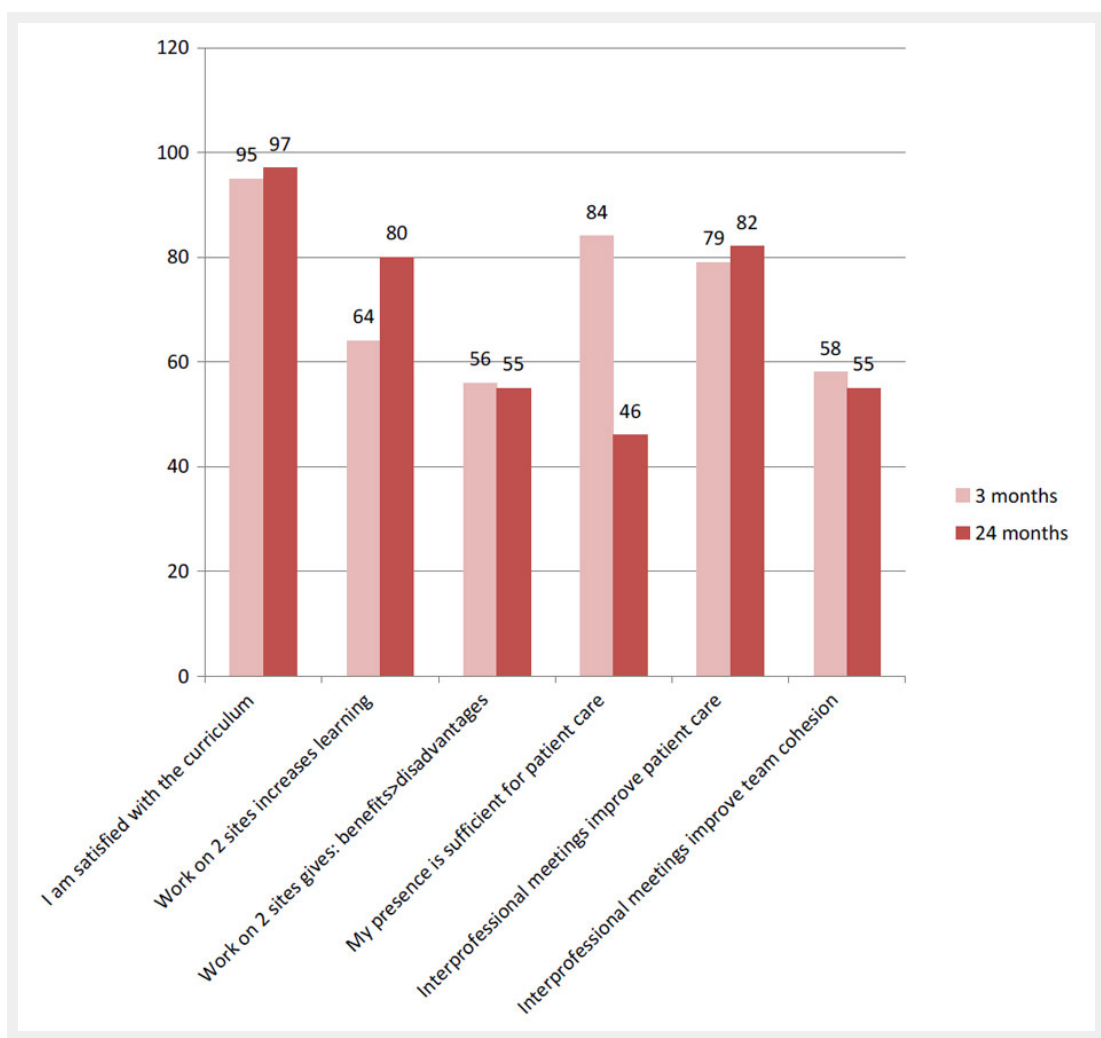
Figure 3 Residents’ satisfaction with the new curriculum at 3 (T3) and 24 (T24) months (expressed in %). Response rate at T3: n = 22, response rate 48%; response rate at T24: n = 11, response rate